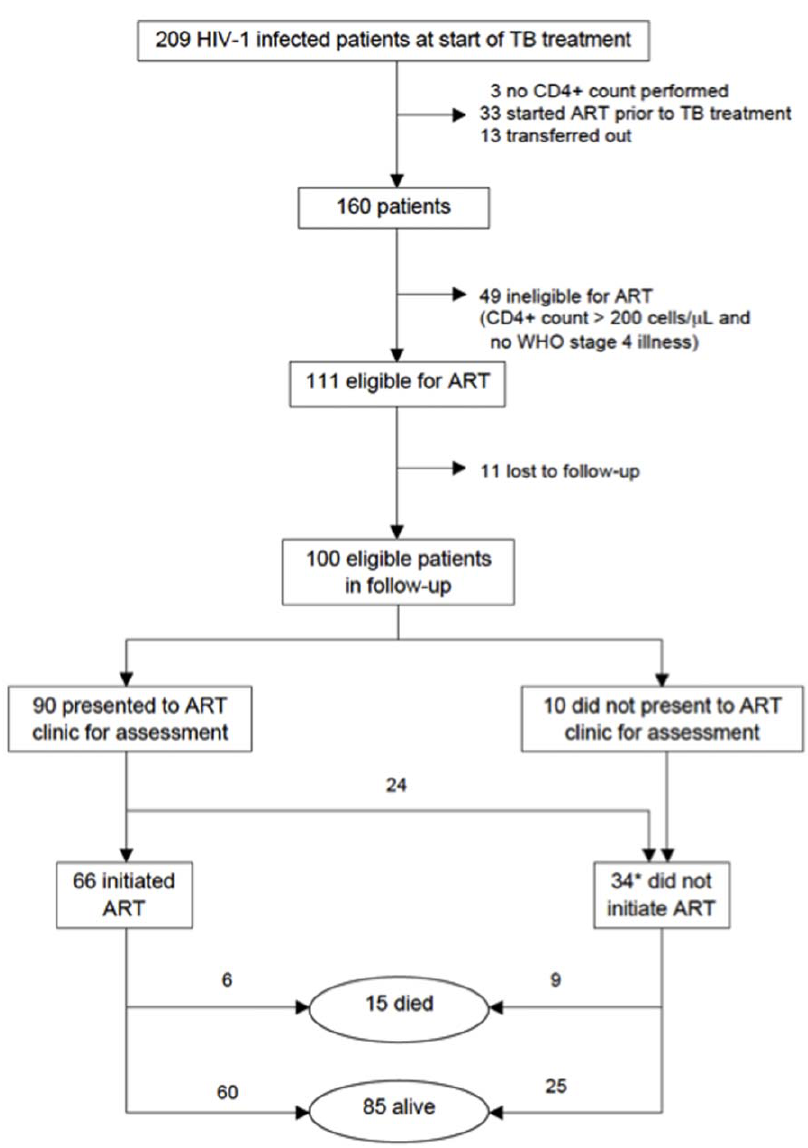
Figure 1. Flow-diagram showing inclusion criteria and outcomes of 100 eligible patients. ART: antiretroviral treatment, TB: tuberculosis, WHO: World Health Organisation, *11 of these 34 patients initiated antiretroviral treatment 4 to 91 days after completion of TB treatment.